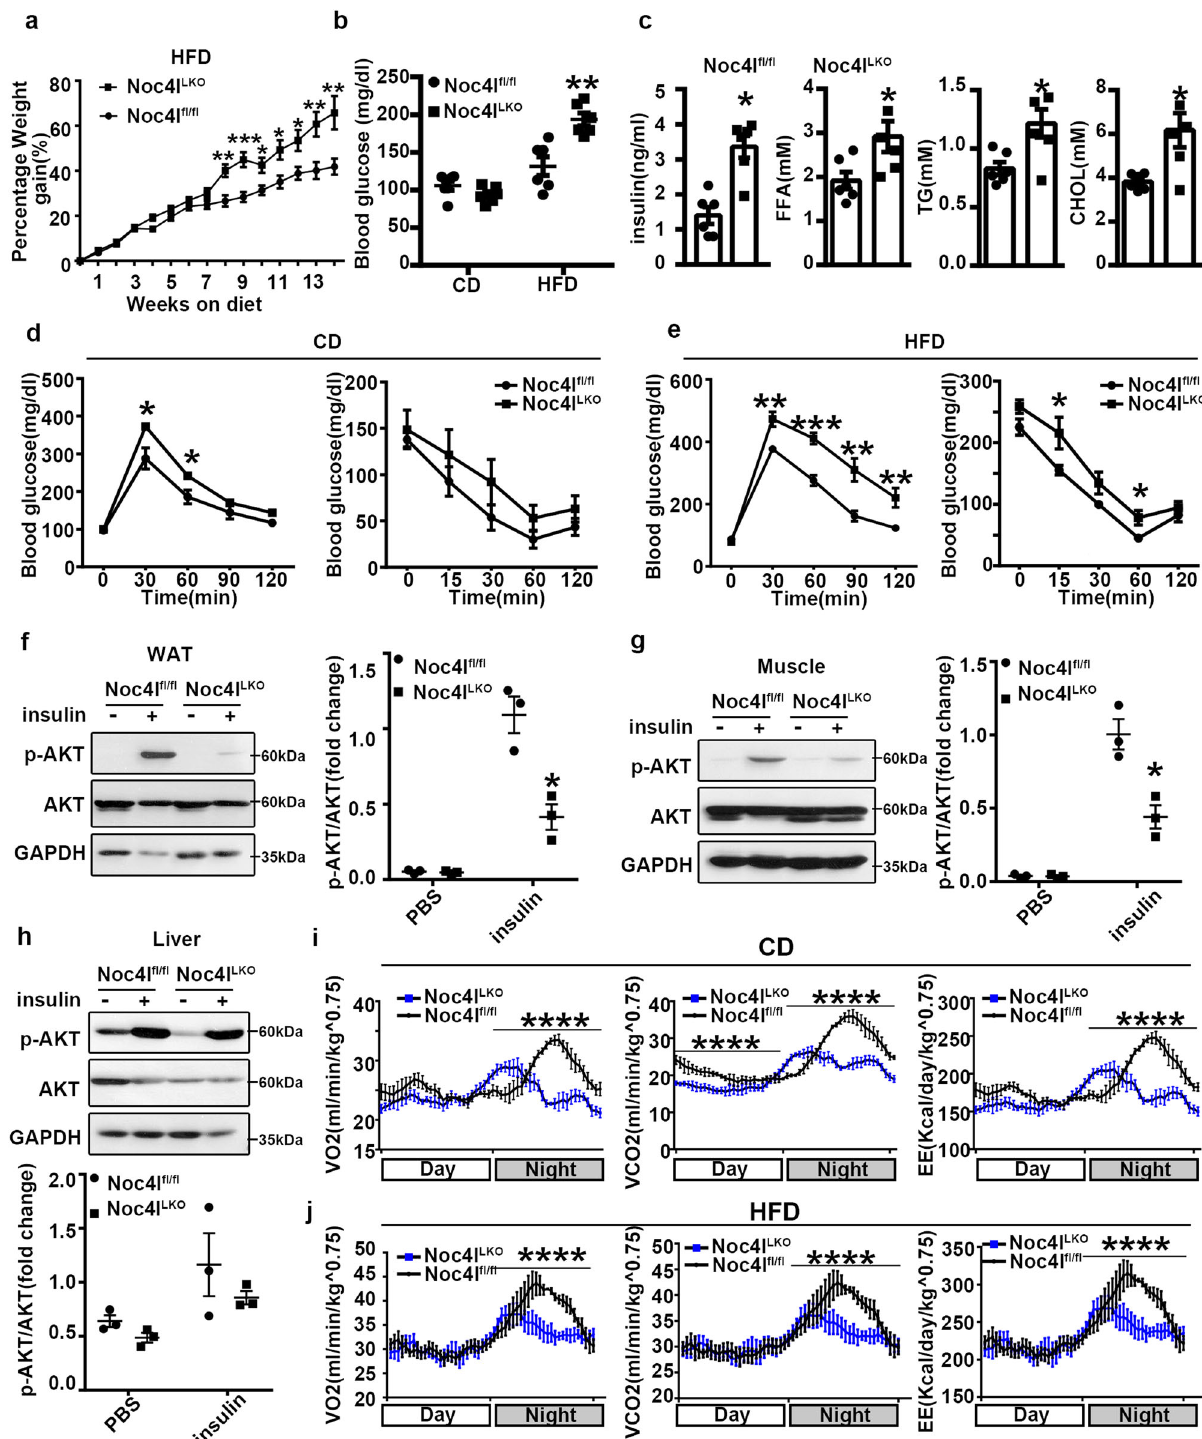
fl uorescence distributed predominantly in nucleus, but also some punctate fl uorescence signals in the cytoplasm (Supplementary Fig. 5b). Furthermore, NOC4L was co-stained with the early endosomal marker Rab5-positive compartments in HeLa cells (Fig. 5l). Moreover, NOC4L was not co-stained with Rab7 (late endosome) or Rab11 (cycling endosome)-positive compartments (Fig. 5l). In addition, NOC4L staining was not detected on other subcellular organelles, such as LysoTracker-positive (acidic compartment, lysosomal marker) or endoplasmic reticulum